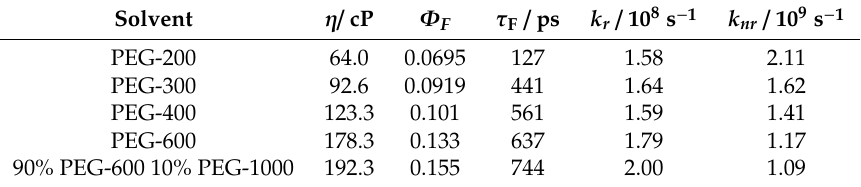
Table 2. Rate coe ffi cients of radiative and non-radiative deactivations ( k r and k nr ) of PhSt in PEG solvents, calculated from the fluorescence quantum yields ( Φ F ) and fluorescence decay times ( τ F ).